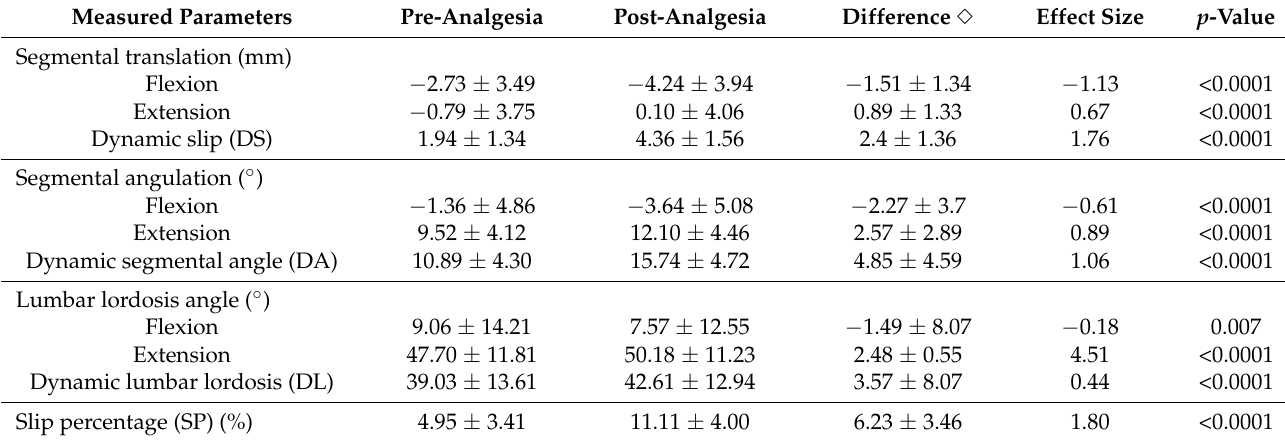
Table 2. Parameters measured from lateral flexion/extension radiographs before and after analgesic injections.